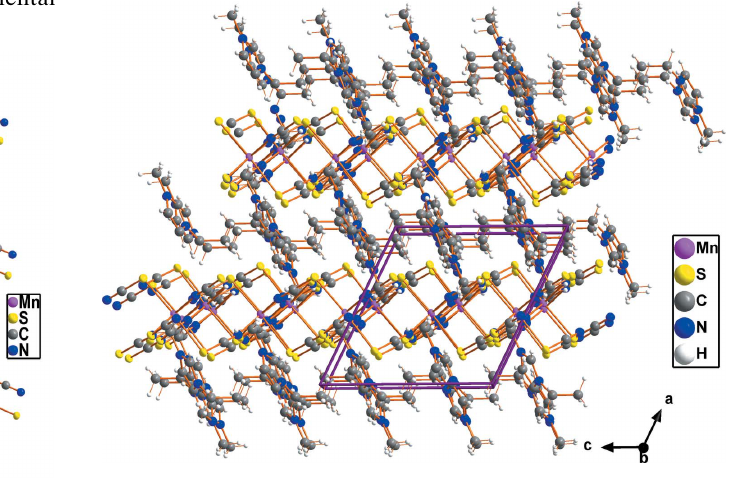
Figure 3 The packing of anionic [Mn(NCS) 3 ] (cid:2) and EMIM + layers along a .